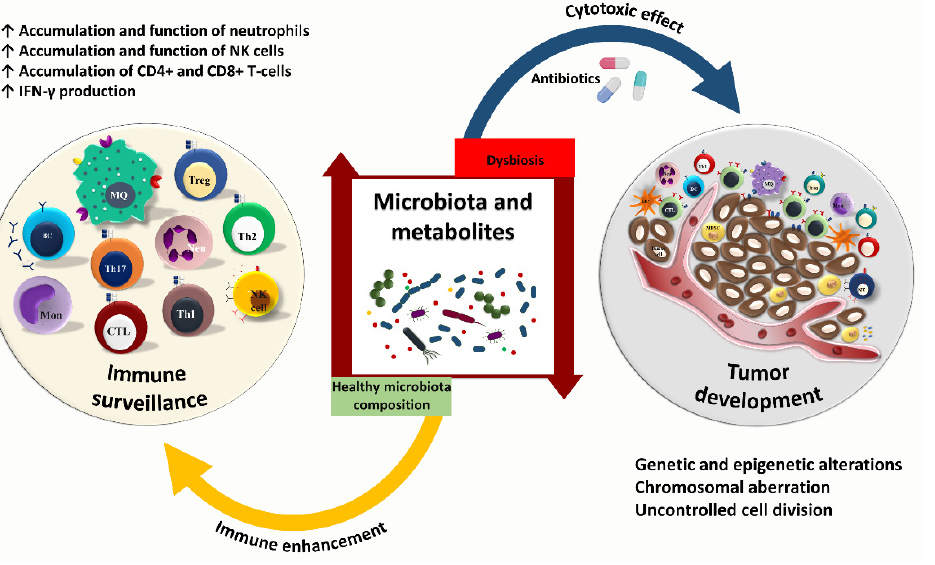
Figure 2. The cancer—microbiota—immune system axis. The gut microbiota plays a critical role in the immune maturation and prevention of cancer development. The increase in commensal microbiota results in the enhancement of the immune system. While the reduction of beneficial bacteria is linked to tumor progression. Healthy microbiota composition potentially increases the accumulation and function of neutrophils, NK cells, CD4 + , and CD8 + T-cells. On the other hand, using antibiotics may lead to dysbiosis, which can negatively affect T-cell function. The perturbation of gut microbiota consequently results in tumor growth and cancer development.